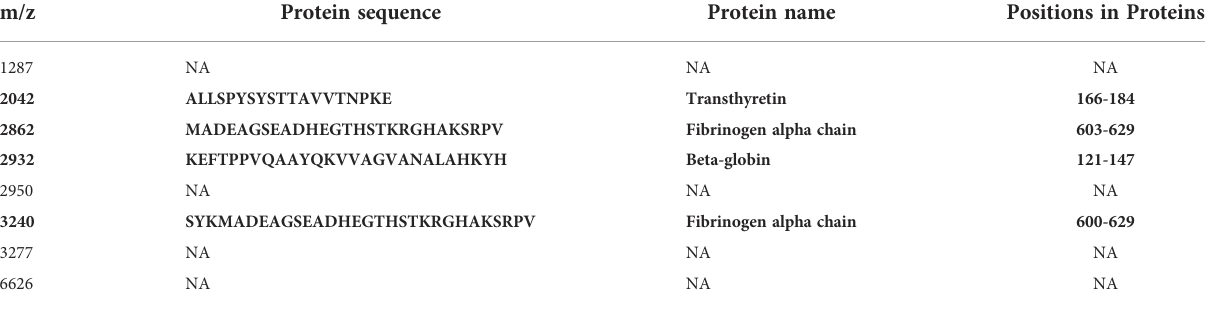
NA, not available. Bold shows the parameters of the four peptide